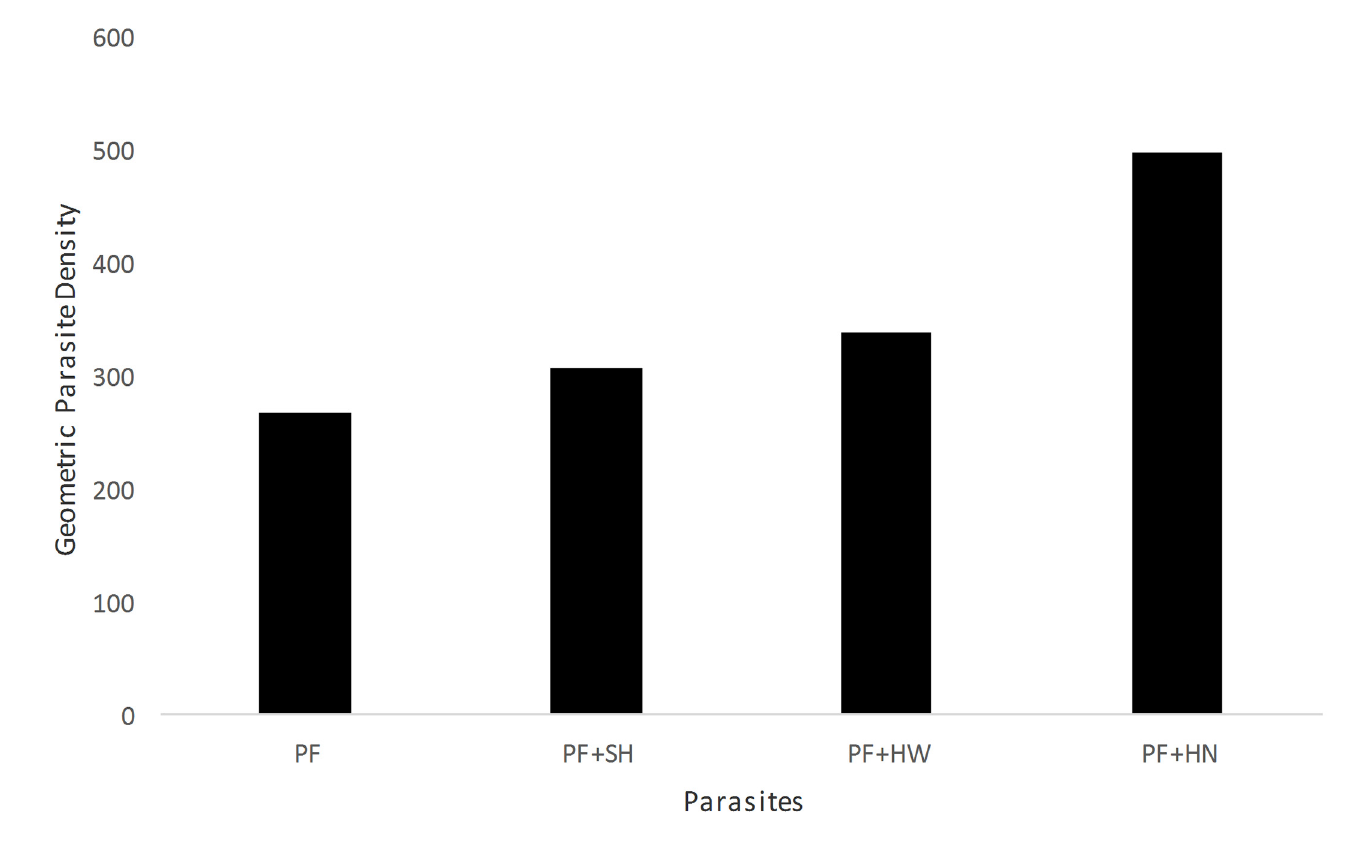
Fig 1. Geometric parasite density per microlitre of blood by type of infection. PF vs PF+HN = p < 0.001; PF + HW Vs PF + SH = p < 0.001;Key: PF = P . falciparum ; SH = S . haematobium ; HW = Hookworm; HN = Hymenolepis